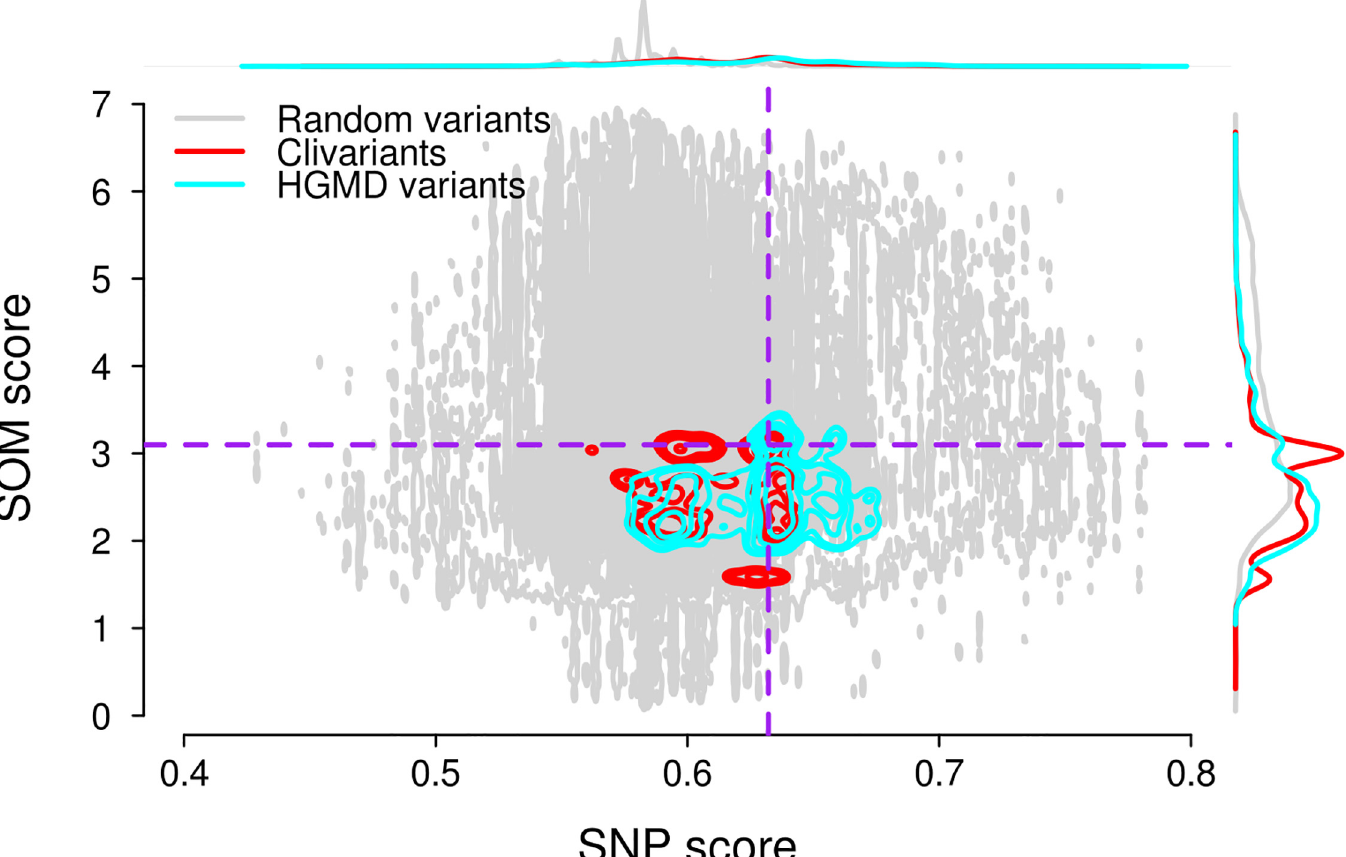
Fig 3. Relationship between SNP and SOM scores in liver cancer. Grey dots: 1 million random genome positions; cyan contour: HGMD disease-causing variant positions; red contour: Clivariant positions. The top and right curves show marginal distributions of SNP scores (top) and SOM scores (right) for random genome positions, HGMD and Clivariant disease-causing variant positions. Dotted lines define cutoff values for hypomutated/hypermutated regions. SNP score cutoff = 0.63 (98.16Mb above cutoff), SOM score cutoffs = 3.10 variants/Mb, defining areas below cutoff of 55.67 Mb, in liver cancer. Hypomutated regions defined by both cutoff correspond to ~56Mb in liver cancer type.